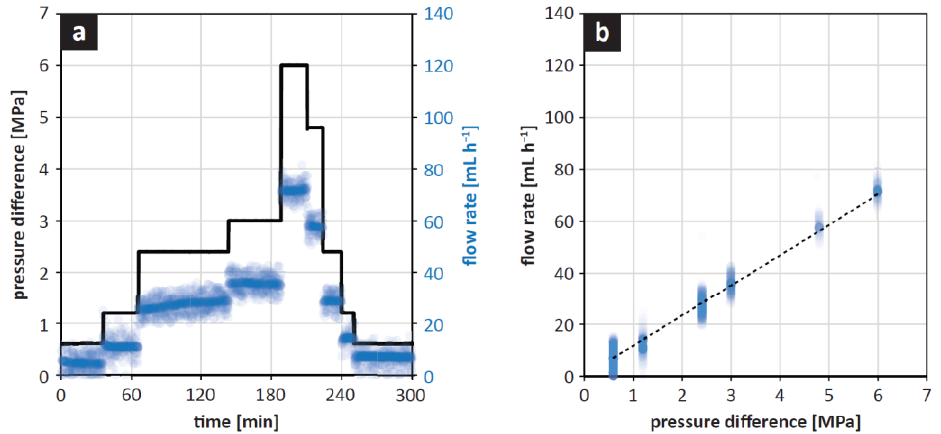
Figure 2. Results of initial, water-based flow measurements on sample BC-1; ( a ) flow rate (in blue) and applied pressure difference (in black) versus time, ( b ) flow rate versus applied pressure difference, showing a roughly linear dependence; the slope of a linear best fit line through these data has been used to calculate the initial equivalent permeability of the sample.